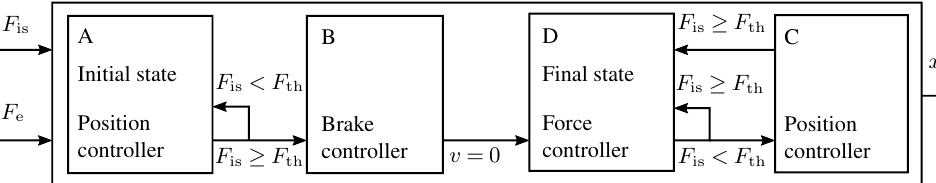
Figure 6. State machine with transition conditions for the contact establishment.